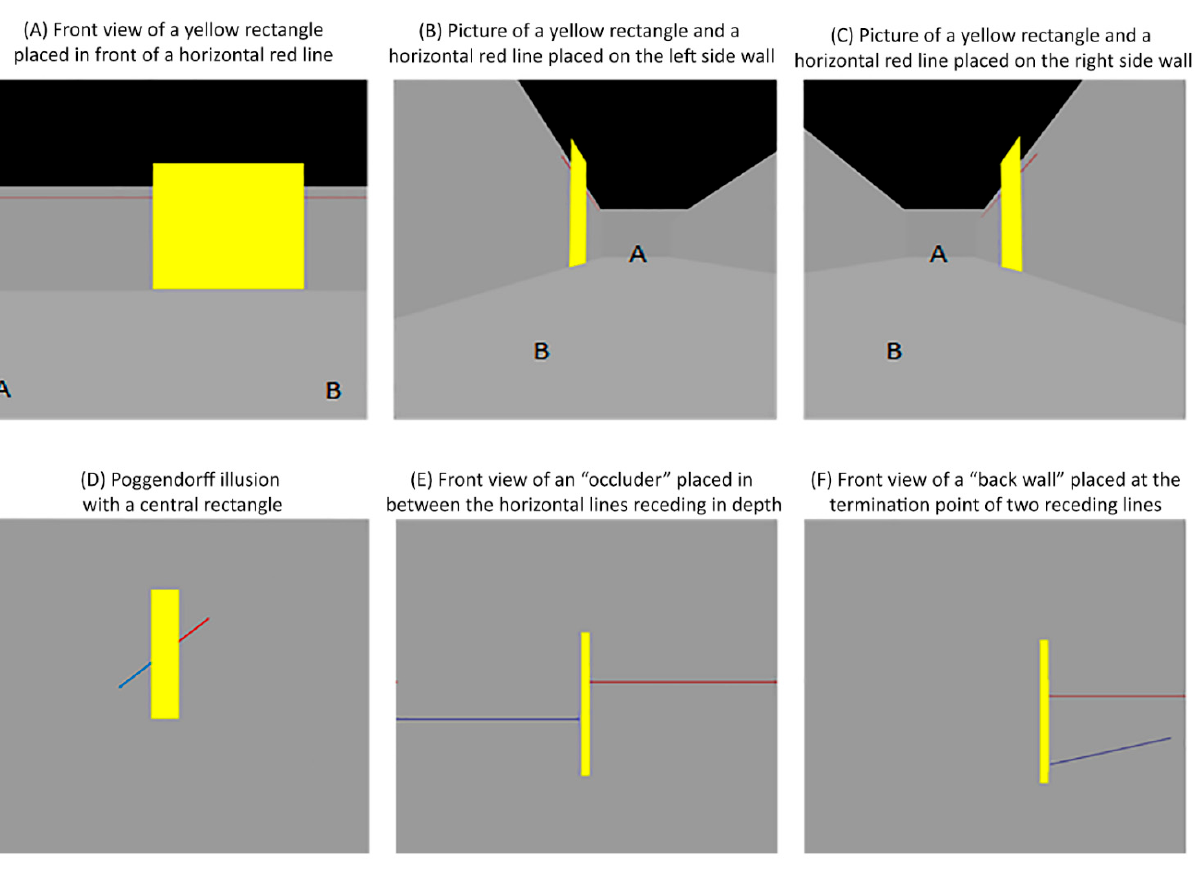
Figure 11. Poggendorff figures used to illustrate the possible interpretations of attached lines and central areas. Pictures of the virtual environments were taken using a virtual camera in Autodesk 3dsMax. ( A ) Front view of a yellow rectangle placed in front of a horizontal red line. The front view image of the yellow rectangle was taken by placing a virtual camera in between points A and B (see Video S1). ( B ) Side view of a yellow rectangle placed in front of a horizontal red line on the left side wall. ( C ) Side view of a yellow rectangle placed in front of a horizontal red line on the right side wall (see Video S1). ( D ) Poggendorff illusion with a central rectangle (see Video S2). ( E ) Front view of an “occluder” placed in between the horizontal lines receding in depth. The side view of this image was illustrated in Figure 2D (see Video S3). ( F ) Front view of a “back-wall” placed at the termination point of two lines receding in depth. The side view of this image was illustrated in Figure 2D (see Video